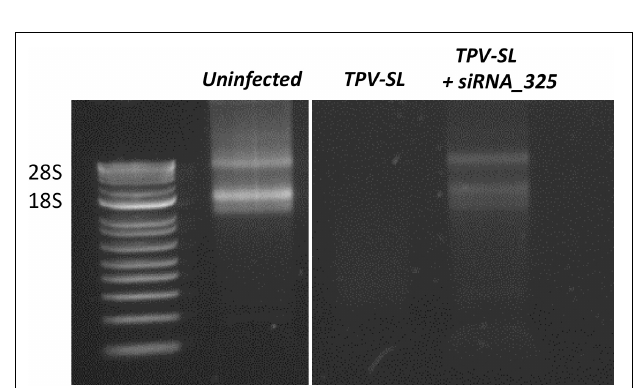
FIGURE 7 | Gene silencing of the RNAse T2 and effect on the rRNA shutdown induced by Tupanvirus infection. Electrophoresis gel showing ribosomal 18S and 28S RNA from A. castellanii under three conditions: uninfected cells, infected cells with Tupanvirus soda lake (TPV-SL) at MOI 100 and infected cells by TPV-SL and